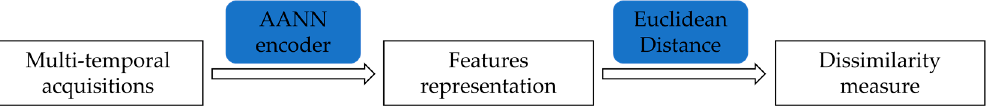
Figure 1. Main steps of the testing phase.